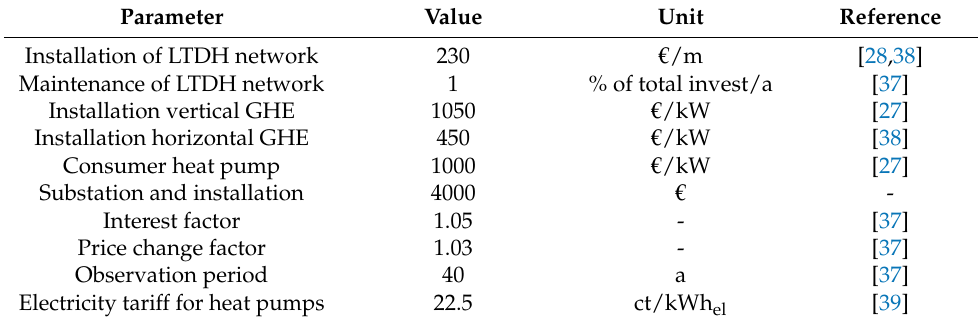
Table 6. Assumptions for the economical assessment.